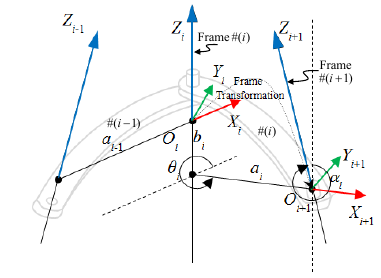
Figure A1. Links and DH